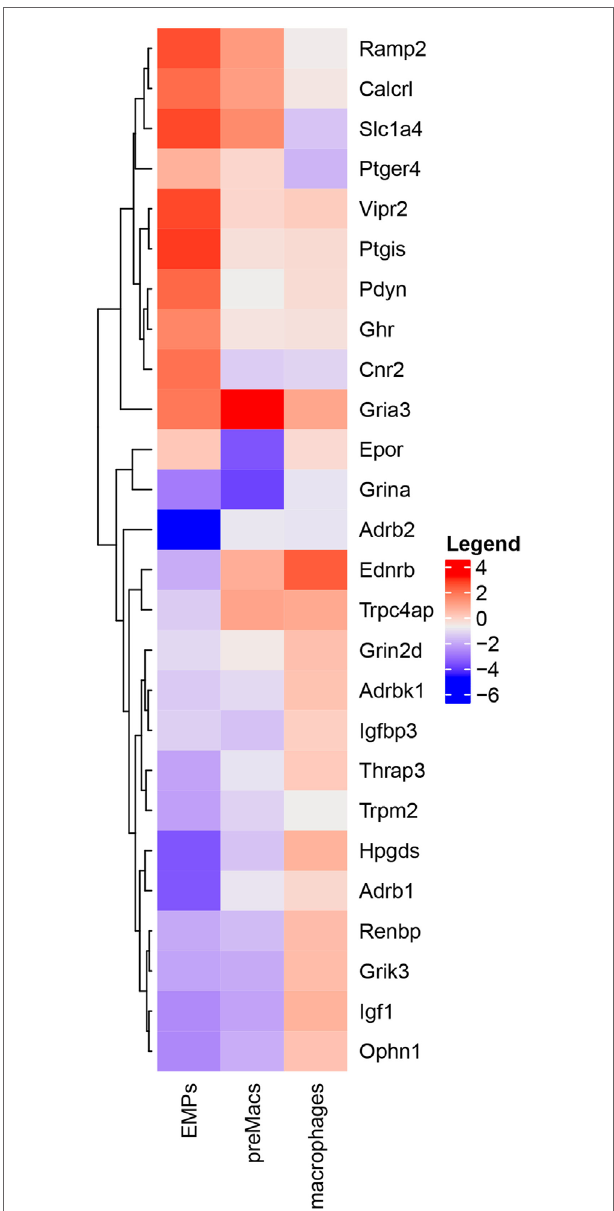
FiGURe 2 | Neuroendocrine-associated genes are differentially expressed during macrophage differentiation. Heatmap of RNA-Seq profile filtered by keywords from Mass et al. (9) depicting hierarchically clustered relative gene expression (log2) in erythro-myeloid progenitors, pre-macrophages (preMacs), and macrophages. Levels of expression are represented by colors in which red, white, and blue indicate high, intermediate, and low intensities,